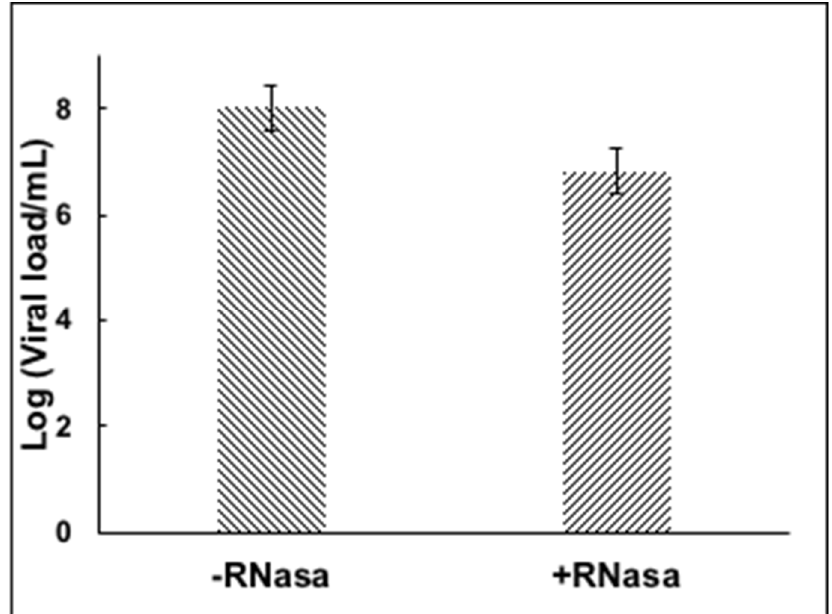
Figure 2. RNase treatment of nasopharyngeal sample containing SARS-CoV-2.